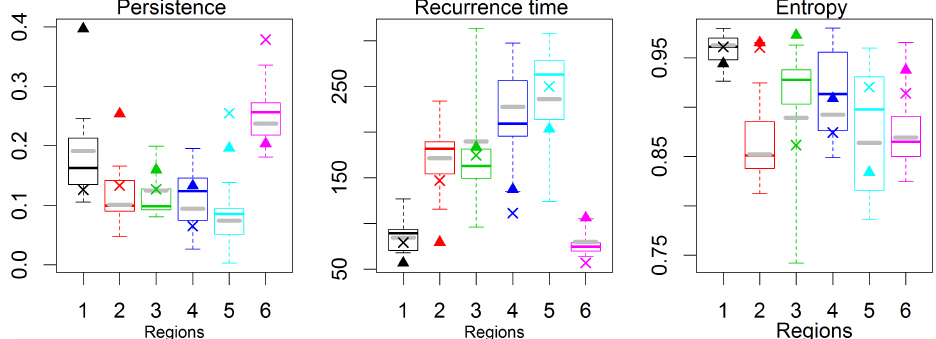
Figure 5. Descriptors for hot and dry extremes in summer (JJA) (Ta > 90th percentile and EDI < 25th percentile) in the reference period 1971–2000 for the six investigation areas. Box plots of the CCLM ensemble: box is the ensemble median and interquartile range and whiskers are ensemble minimum/maximum; gray bars: ensemble mean; triangles: reanalysis-driven CCLM runs; crosses: E-OBS observations. The coloring corresponds to the regions in Fig.